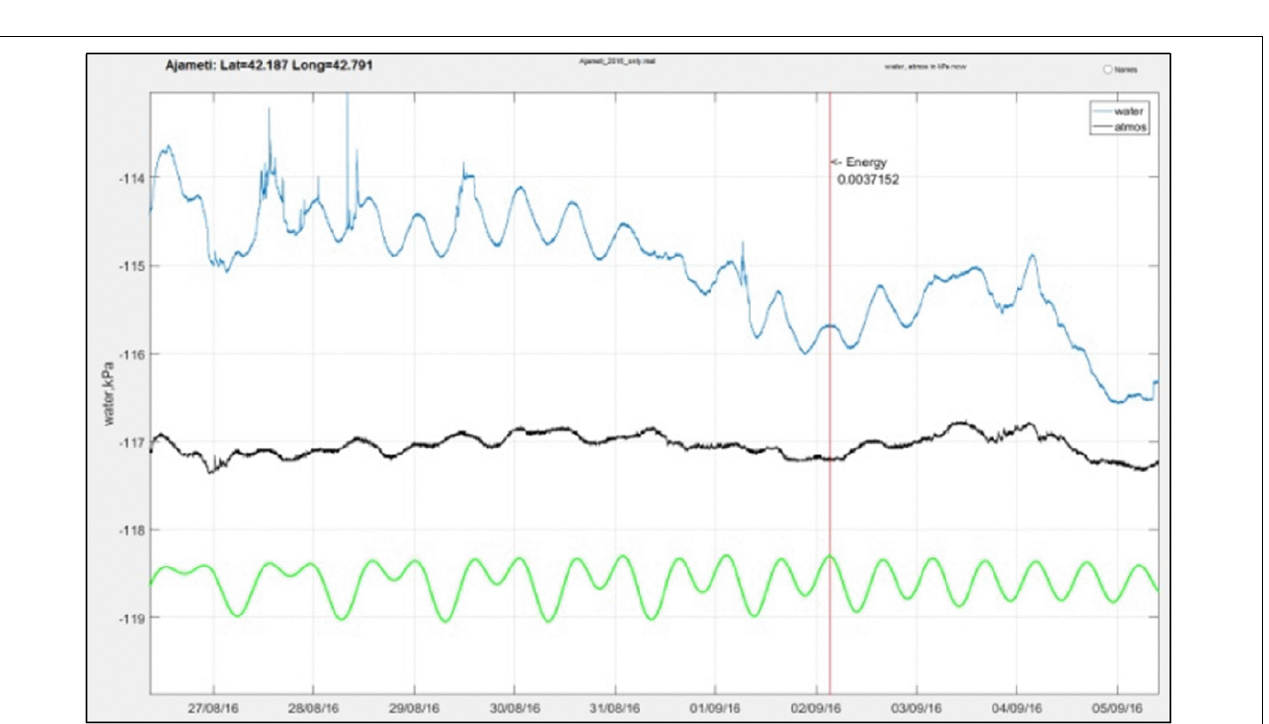
FIGURE 3 | Recording of WL (blue), barometric pressure (black), and computed tidal variations (green) in the Ajameti well before and after the 02/09/2016 Gagra EQ (M4), marked by the red line.